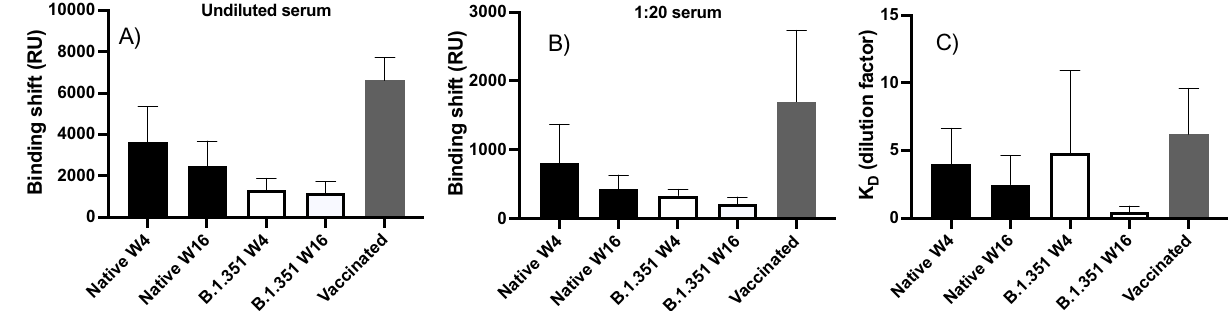
Figure 3. SPR binding shift for undiluted serum ( A ) and serum at a 1:20 dilution ( B ) from SARS-CoV-2- positive individuals at weeks 4 (W4) and 16 (W16) post-diagnosis for the native (black, n = 16, 4 age groups) and B.1.351 (white, n = 4, 18–49 years) spike proteins, and for vaccinated individuals (gray, n = 5) for the native spike protein. ( C ) A dissociation constant was estimated from the dilution series assuming a 1:1 binding model according to the data presented in panels ( A ) and ( B ). The dilution series used in SPR data acquisition consisted of the following: 1:40, 1:20, 1:10, 1:5, 1:2.5 and undiluted serum. In all panels, error bars represent one standard